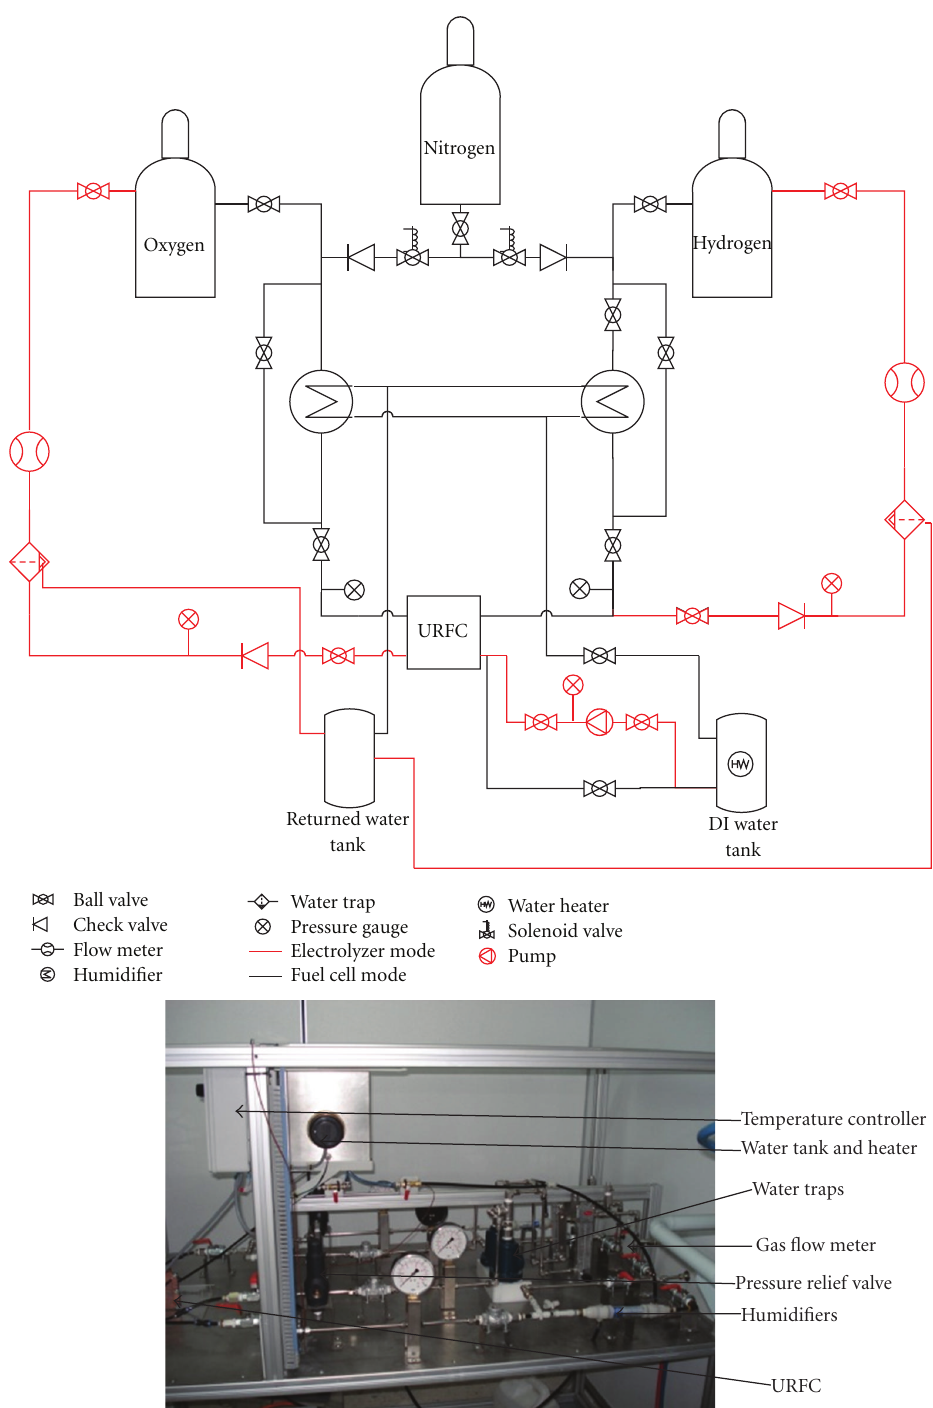
Figure 2: The hydrogen system